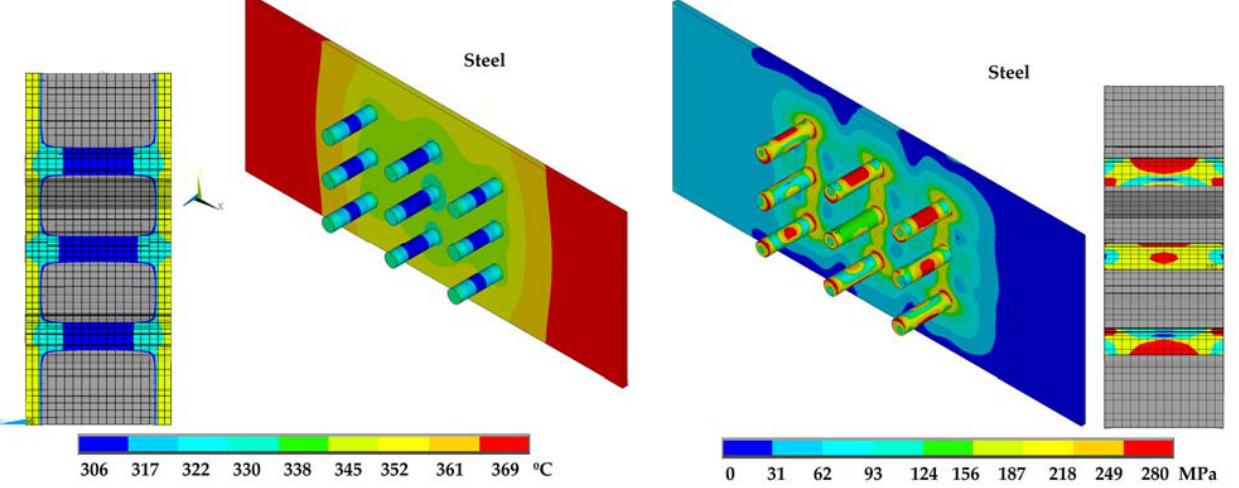
Figure 21. Temperature ( left ) and equivalent stress (von Mises) ( right ) in the steel elements, both with the middle cross ‐ section, at 300 s.